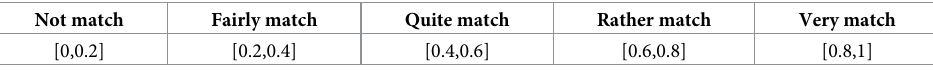
Table 1. Evaluation scale of inaccurate linguistic preference